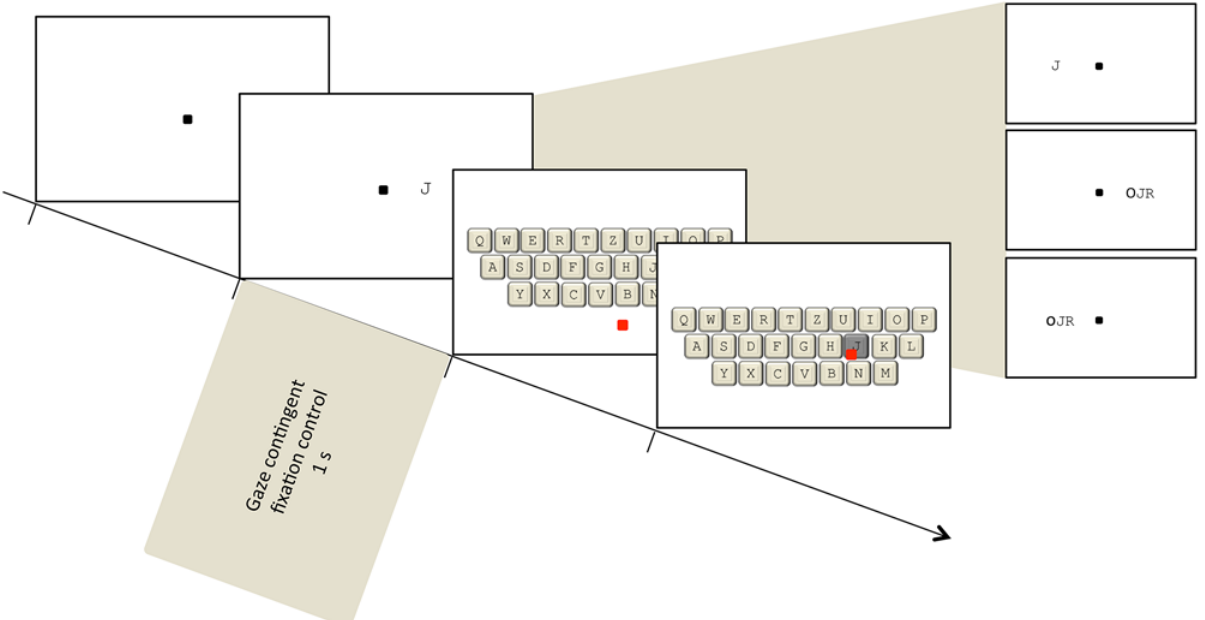
Fig 1. Procedure for the Extrafoveal Vision Assessment (EVA). After a fixation period of 1 s, the target stimulus was presented for 1 s. Horizontal eccentricity of the target stimulus was varied from trial to trial using an adaptive stair-case procedure. The response was given on a digital keyboard using the computer mouse. The right part of the figure depicts the other three experimental conditions: left-hemifield single letter identification, as well as left- and right- hemifield identification of flanked